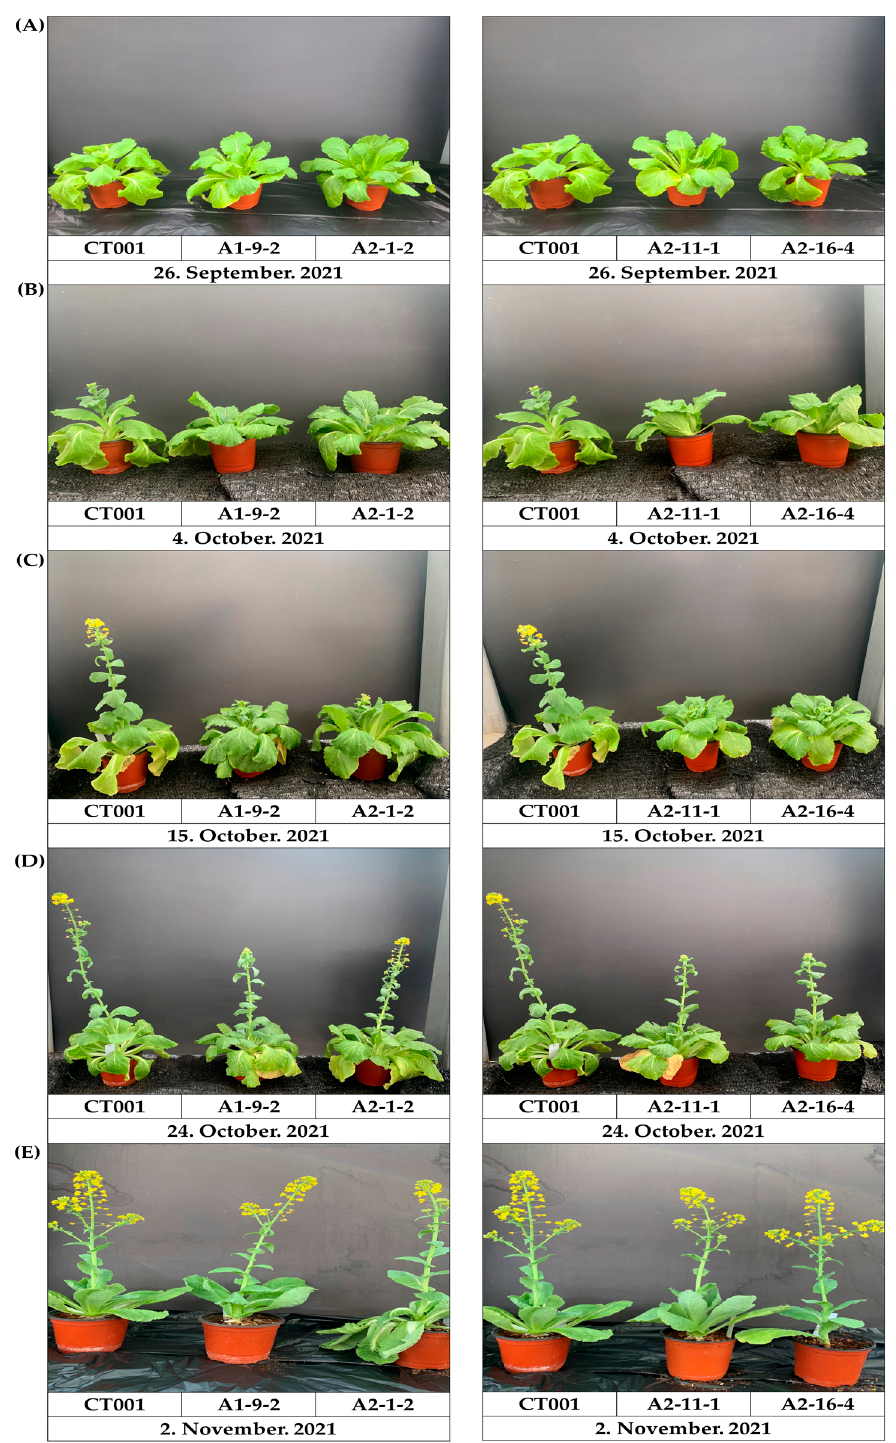
Figure 7. Observation of the bolting and vegetative growth of the inbred line ‘CT001 (cid:48) and the T- DNA-free E 1 AGL -edited lines. ( A ) Vegetative stage before bolting. ( B ) Beginning stage of bolting. ( C ) Early stage of bolting. ( D ) Middle stage of bolting. ( E ) End stage of bolting. Left, inbred line ‘CT001 (cid:48) ; middle and right, T-DNA-free E 1 AGAMOUS-like (AGL) -edited